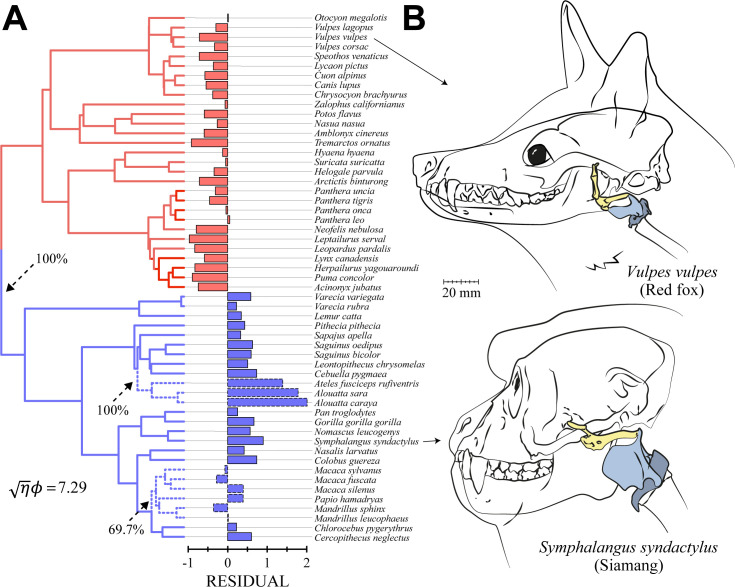
Ornstein-Uhlenbeck model results.(A) Phylogenetic tree and residuals from a pGLS regression of larynx size to log body-length. Carnivorans (red) exhibited smaller larynges than expected based on body size, whereas primates (blue) exhibited larger larynges. Among primates, atelids exhibited exceptionally large larynges (upper set of dashed lines), and papionines exhibited exceptionally small larynges (lower dashed lines). Arrows indicate where grade shifts in mean larynx size are estimated to have arisen; percentages indicate support for these estimations from a bootstrap analysis (see Methods). (B) Computer larynx models derived from CT scans depicted in situ for two species with comparable body lengths (71.4 cm for the red fox and 68.5 cm for the siamang), showing the larger relative size of the primate larynx. The data used to create this figure are located in S1 Data, sheet B, columns B and C. CT, computed tomography; pGLS, phylogenetic generalized least squares.